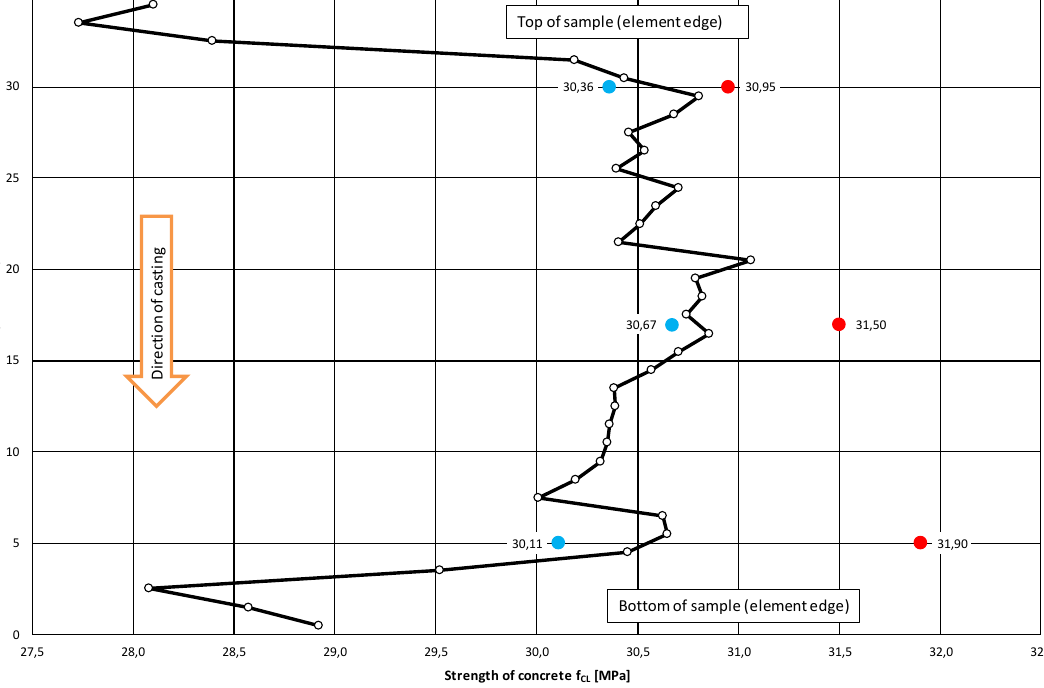
Figure 11. The mean distribution of compressive strength f CL of concrete along the height of the sample taken parallel with the top surface of the slab. The diagram includes the mean concrete